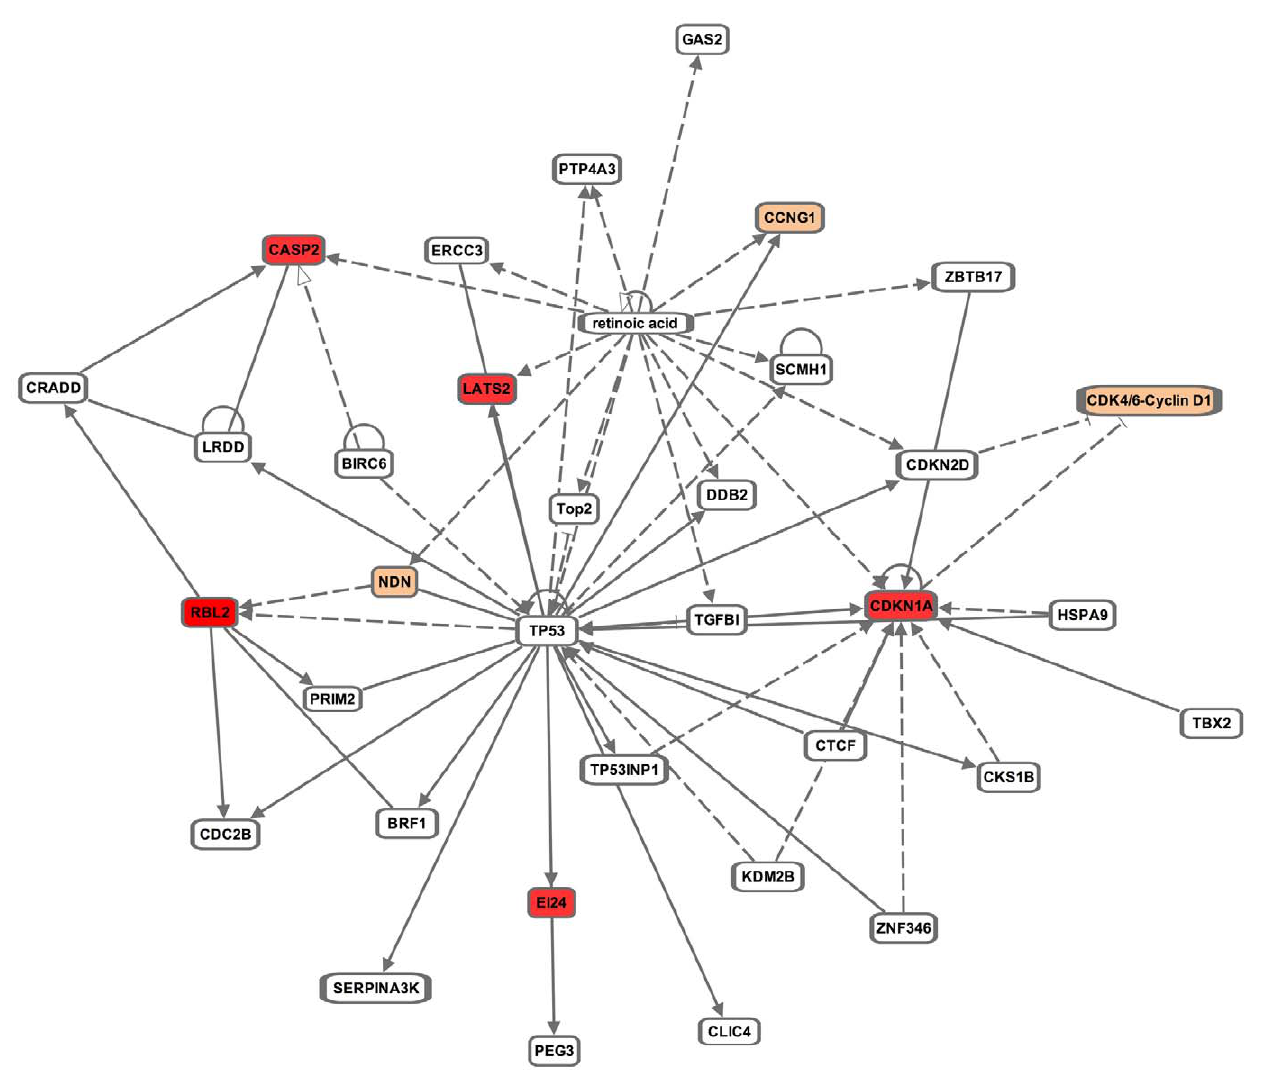
Figure 6. Ingenuity Pathway Analysis (IPA) of miR-295 targets. IPA was performed for validated targets of miR-295 from this and prior studies [10,11,12], and identified the network, ‘‘Cell Death, Cell Cycle, Cellular Function and Maintenance,’’ which centers around p53. Solid lines indicate direct interactions and dashed lines indicate indirect interactions. Validated targets of miR-295 are shown in red and computationally predicted targets are shown in orange.